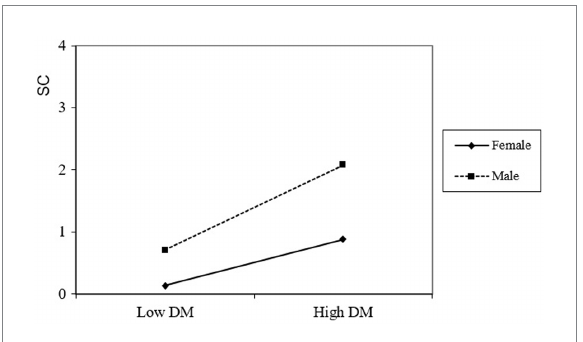
FIGURE 2 The moderating effect of gender in the association between dispositional mindfulness and self-compassion.